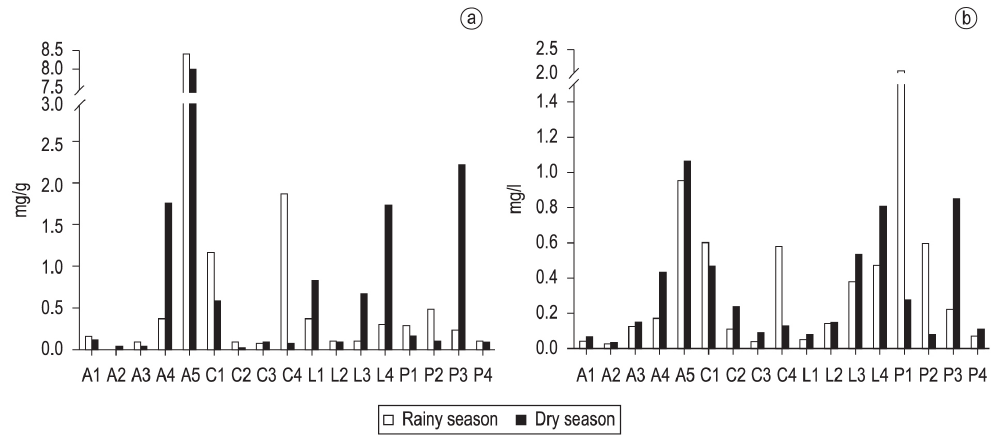
Figure 5. Variation of nitrogen (a) and phosphorous (b) concentration in sediment samples of Araquá, Capivara, Lavapés and Pardo Rivers in rainy and dry season.